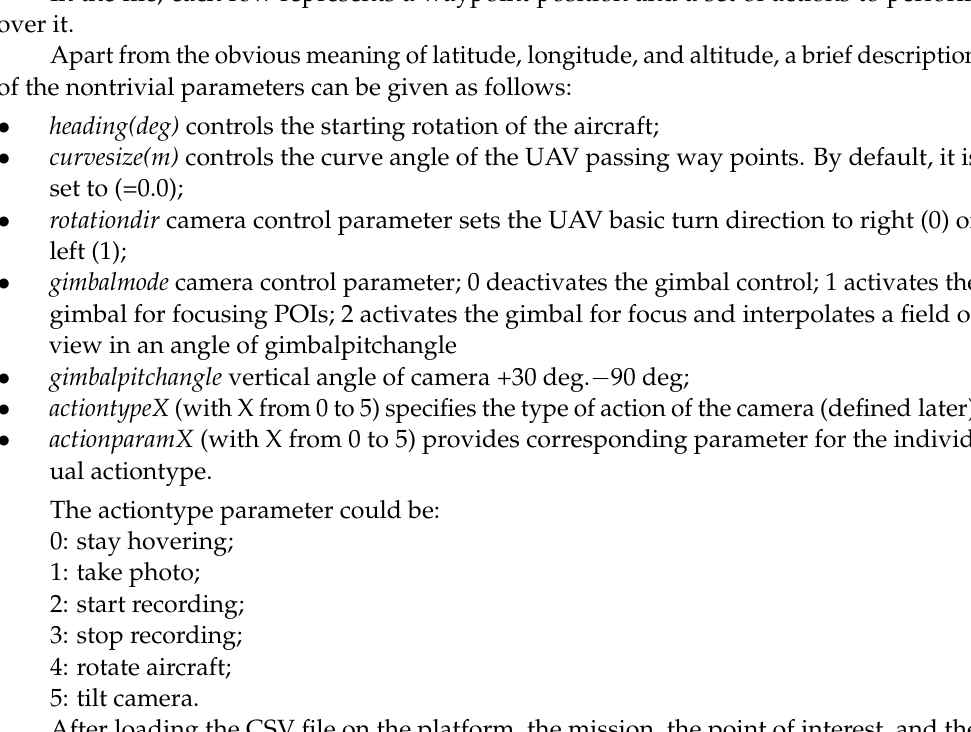
Figure 8. The mission is managed through the drone controller. The drone sends the real-time video via YouTube, through the mobile phone connected to the drone controller. After the mission’s end, its status changes from ‘ongoing’ to ‘completed’ and the video shot from the drone becomes available to the decision-maker on the map of the smart city (from the widget related to the mission). 3. Results The on-field testing activity covered the whole presented solution, from the alert to the end of the drone mission, managed through the Smart City platform. Unfortunately, a large no-fly zone, due to restrictions on drones over military and urban areas, led to the choice of a rural place about 15 km from Cagliari. There, three people used a drone simulating an operational base (see Figure 9), another person went nearby with a mobile phone to send alerts, while a person from the office pretended to be the decision-maker and selected one of the alerts to request an inspection by drone. It must be specified that in a real context the number of people required is lower than the number of people that were involved in the on-field simulation; in fact, only one person is sufficient to make the report, who is supposed to be a common citizen willing to communicate a risk situation. To manage the smart city platform, the decision-maker can lead the environmental inspection along with a flight planner, and a pilot (but they can be the same person). It must be said that in some countries (such as in Italy), due to the already mentioned safety issues, the drone operator must guide the drone without losing sight of it, but drones are already technically able to replace humans in environmental inspections.